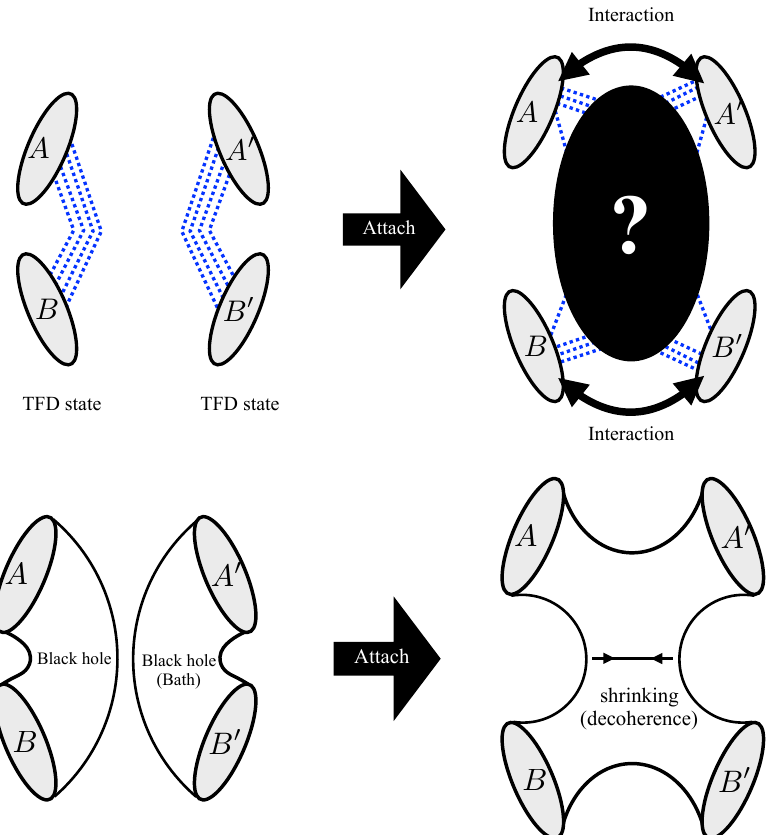
Figure 1 . Our toy model of holographic decoherence. We start from two thermo-field double states (upper-left panel) and its dual two-sided blackholes (lower-left panel). Here blue dotted lines in the upper-left panel represent the entanglement. First we attach these systems by introducing an interaction between A and A 0 , B and B 0 as well. Then, these interactions cause an energy flow between A and A 0 , and one between B and B 0 . We would like to ask the entanglement structure in the final process of this decoherence (upper-right panel). Our process can be holographically viewed as a shrinking of a neck between A and B (or A 0 and B 0 ) which represents a magnitude of the entanglement between them (lower-right